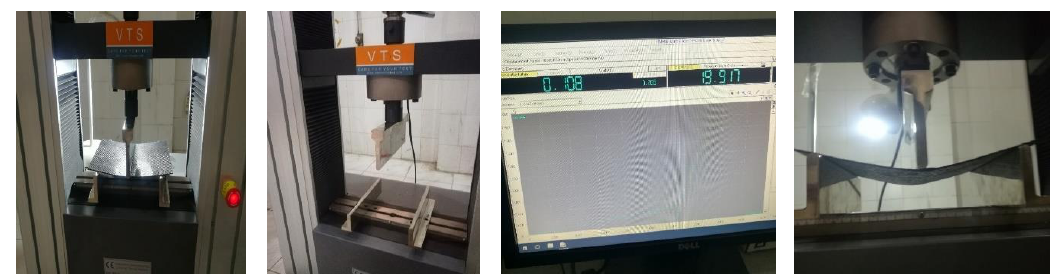
Figure 13. Composite plate manufacturing process.